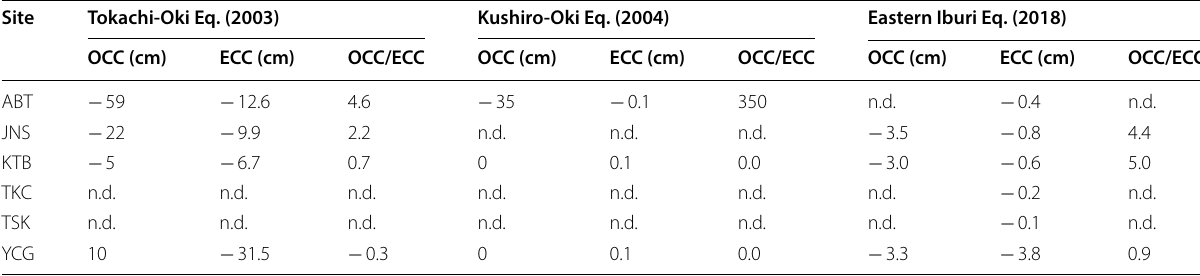
Table 4 Comparison of coseismic changes between the 2003 Tokachi-Oki, the 2004 Kushiro-Oki, and the 2018 Hokkaido Eastern Iburi